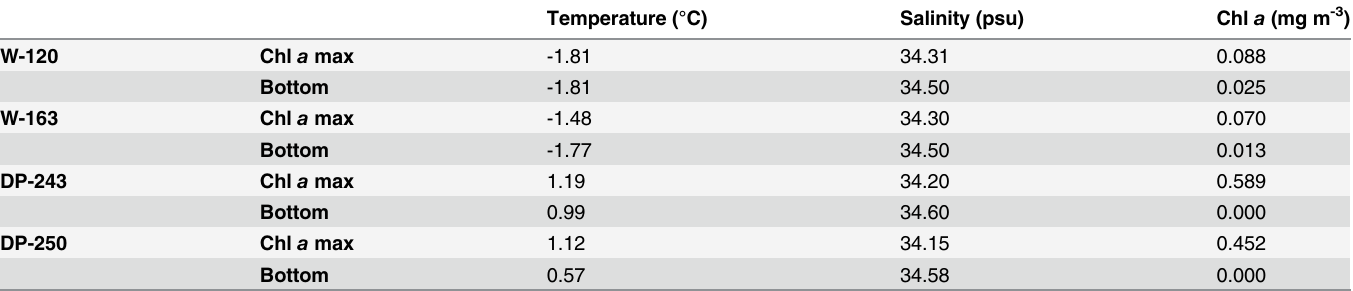
Table 2. Water column properties at chl a max and bottom depth. Temperature and salinity are derived from CTD recordings, chl a from laboratory measurements.